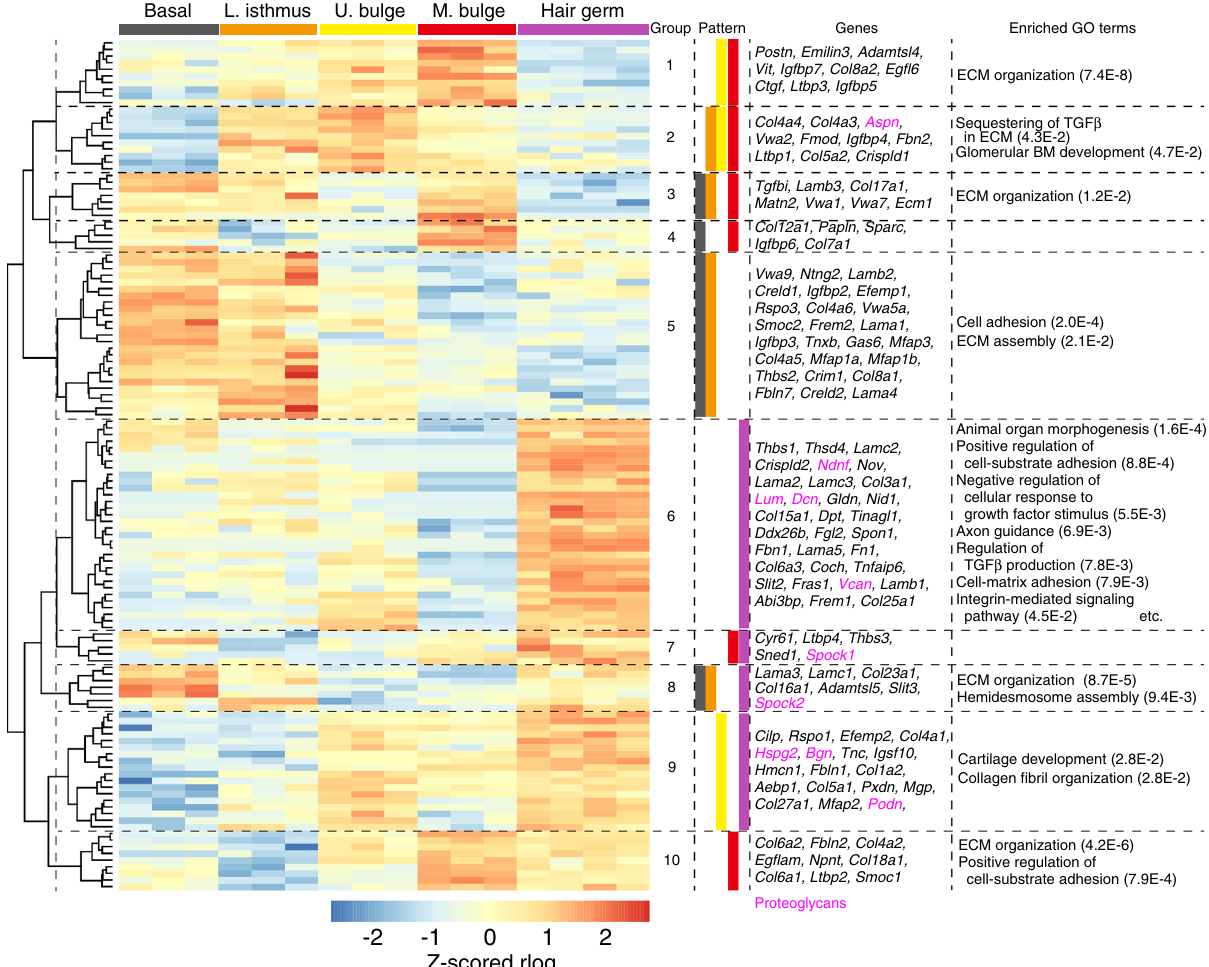
Fig. 3 Hierarchical clustering of differentially expressed matrisome genes in epithelial sub-populations. Z -scored expression values (rlog normalized values) of each biological replicate are indicated according to a heat gradient as shown at the bottom of the heatmap. Dendrogram tree was cut at the height where it gave ten sub-gene groups (epi-groups 1 – 10). To annotate ECM gene expression patterns in each epi-group, the epithelial regions were statistically divided into two groups by k -means clustering. The cell group expressing the cluster-composing ECM genes at a level higher than the other group was classi fi ed as epithelial regions showing relatively high expression of cluster-composing ECM genes. The expression patterns of each epi-group are colour encoded. Genes in magenta indicate proteoglycans. Enriched GO terms analyzed with region-speci fi c ECM genes are shown with their FDR